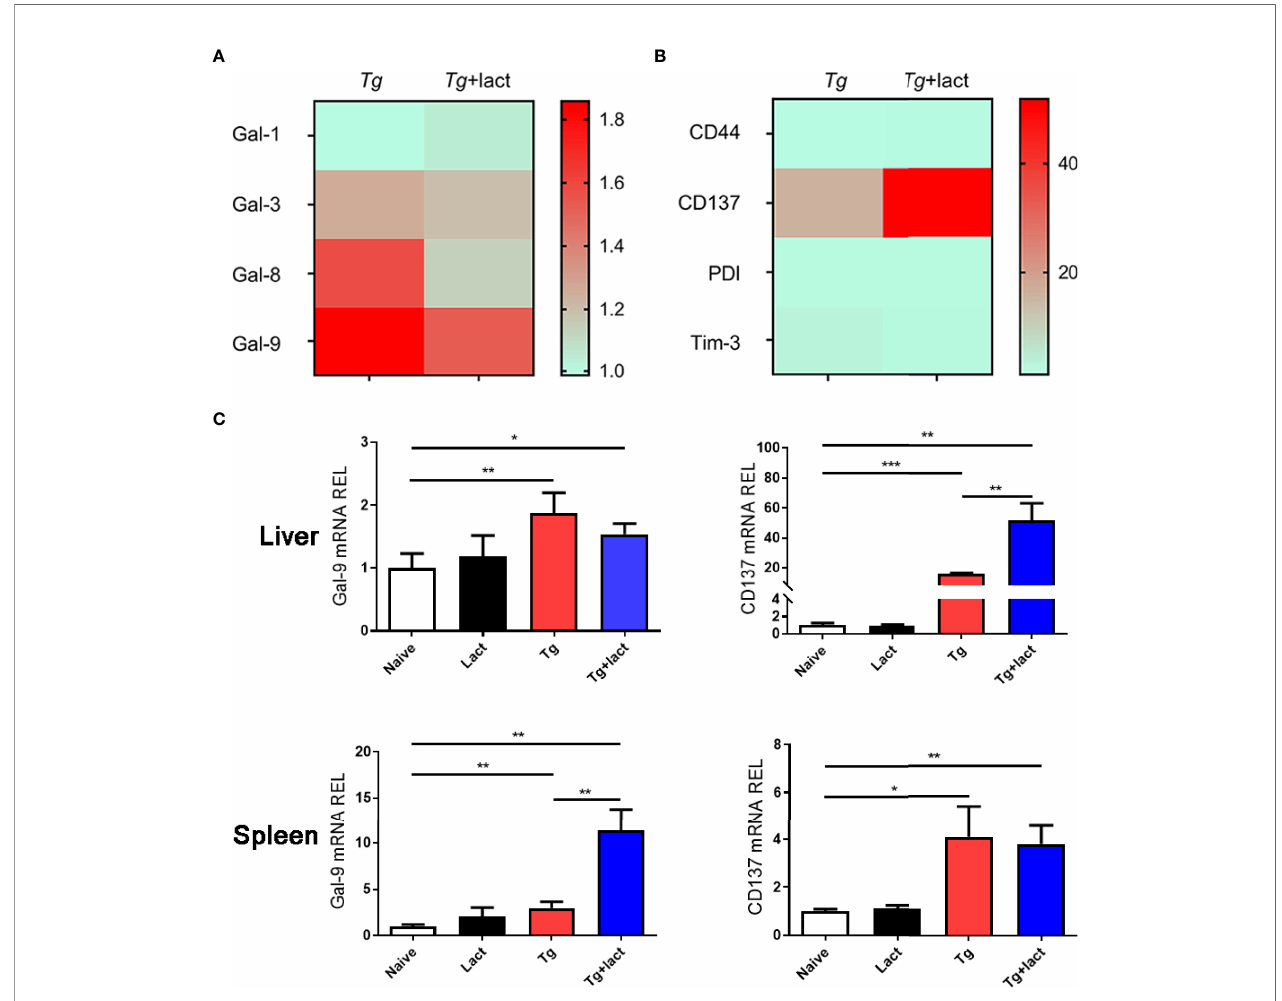
FIGURE 4 | Gal-9 and its receptor CD137 were upregulated during T. gondii infection. Heatmap visualization showed the mRNA expressions of Gal-1, Gal-3, Gal-8, and Gal-9 (A) and the receptors of Gal-9 (CD44, CD137, PDI, and Tim-3) (B) in the livers of Tg -infected mice and Tg +lact mice, while histograms showed the expression levels of Gal-9 and CD137 in the livers and spleens of mice from different groups (C) . Liver and spleen tissues were collected on day 7 p.i. for evaluating mRNA expression levels by using qRT-PCR. Values are means from triplicate measurements, and data are presented as means ± SD; two independent experiments were performed with four mice per group. * P < 0.05, ** P < 0.01, and *** P < 0.001. Y axis represents the mRNA relative expression level (REL) of different